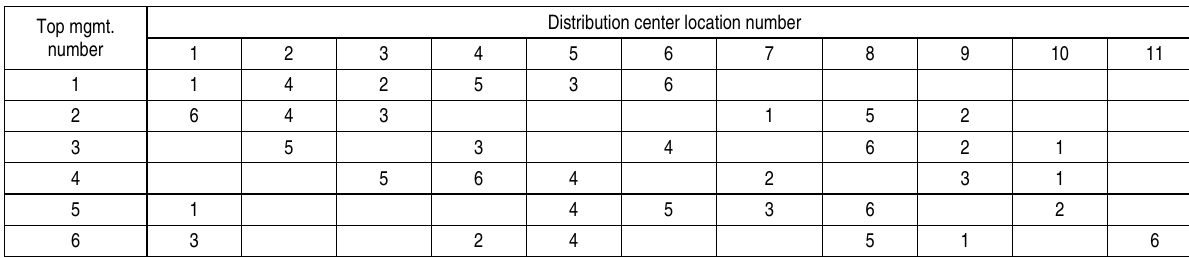
Table 8. Results from BIBD for distribution center location preference study Top mgmt.